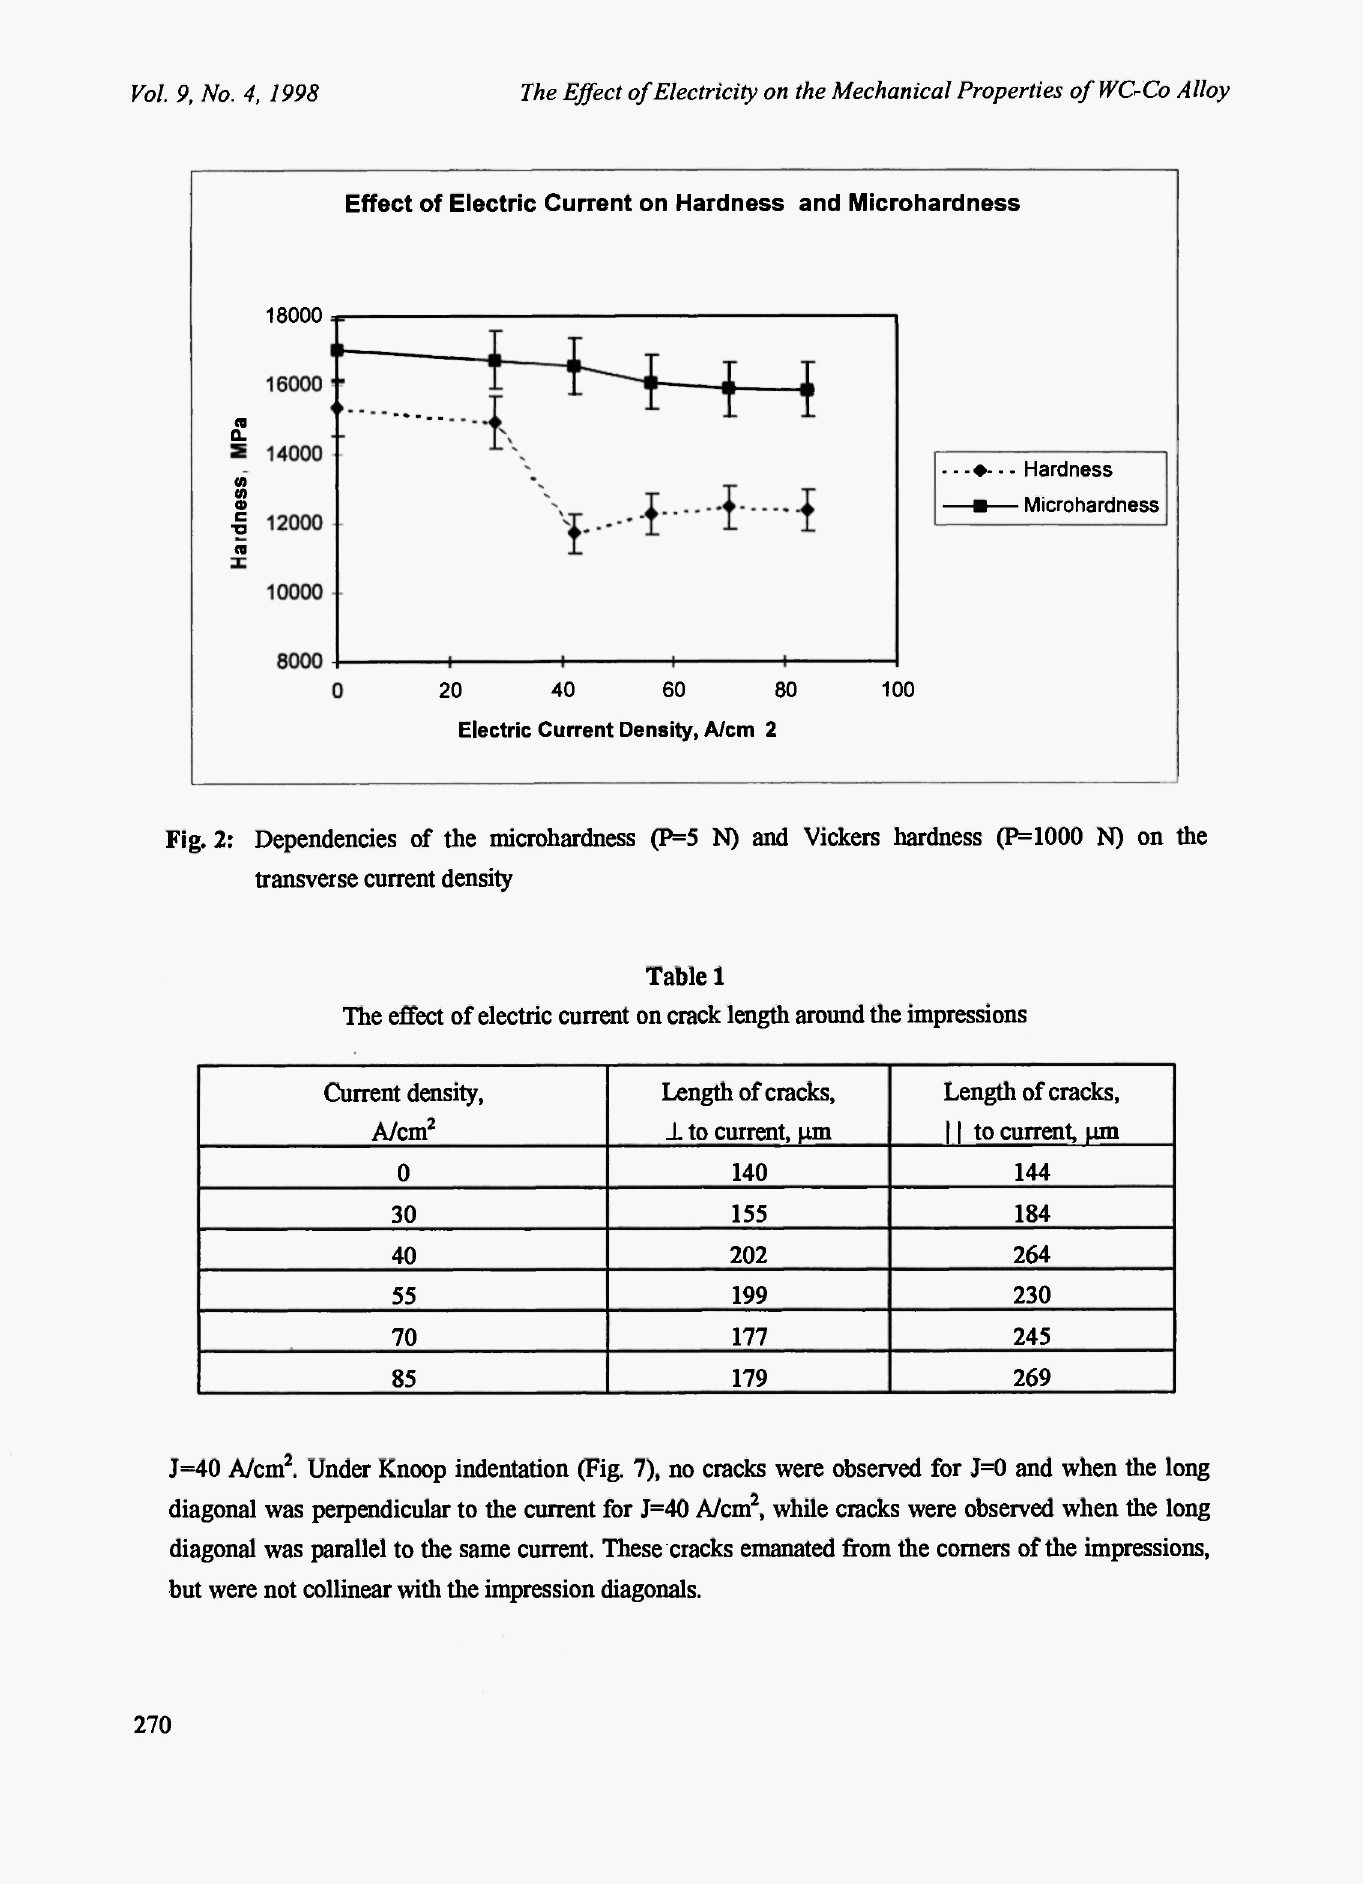
Fig. 2: Dependencies of the microhardness (P=5 N) and Vickers hardness (P=1000 N) on the transverse current density